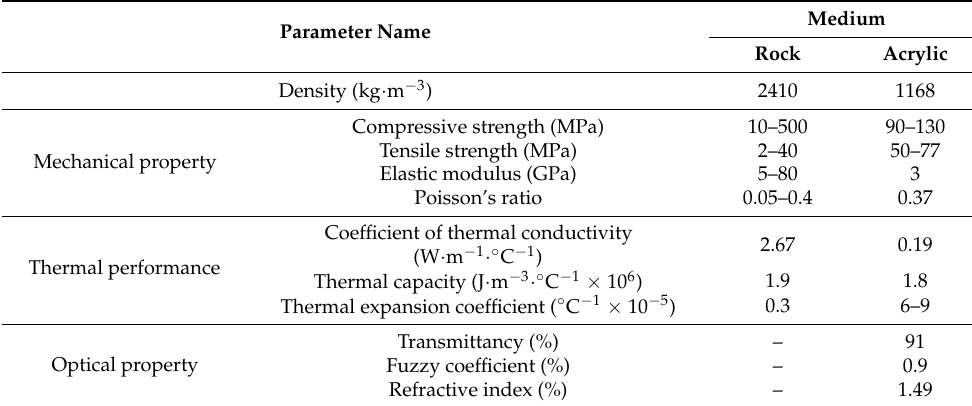
Figure 1. Schematic of the acrylic sample size (The dot indicates the position of the thermocouple). Table 1. Mechanical parameters of the rock and acrylic.